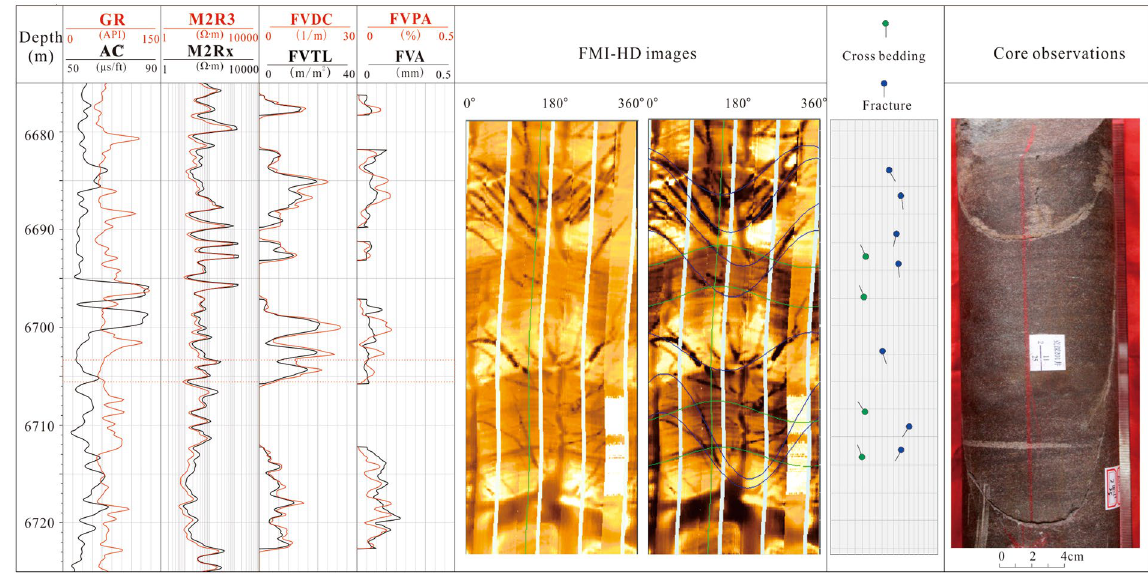
Figure 2. Fracture analysis using a combination of cores and image logs (GR: Gamma Ray; M2R3 and M2Rx: high definition induction log; AC: Acoustic log; FVDC: fracture density; FVTL: fracture length; FVPA: fracture porosity; FVA: fracture